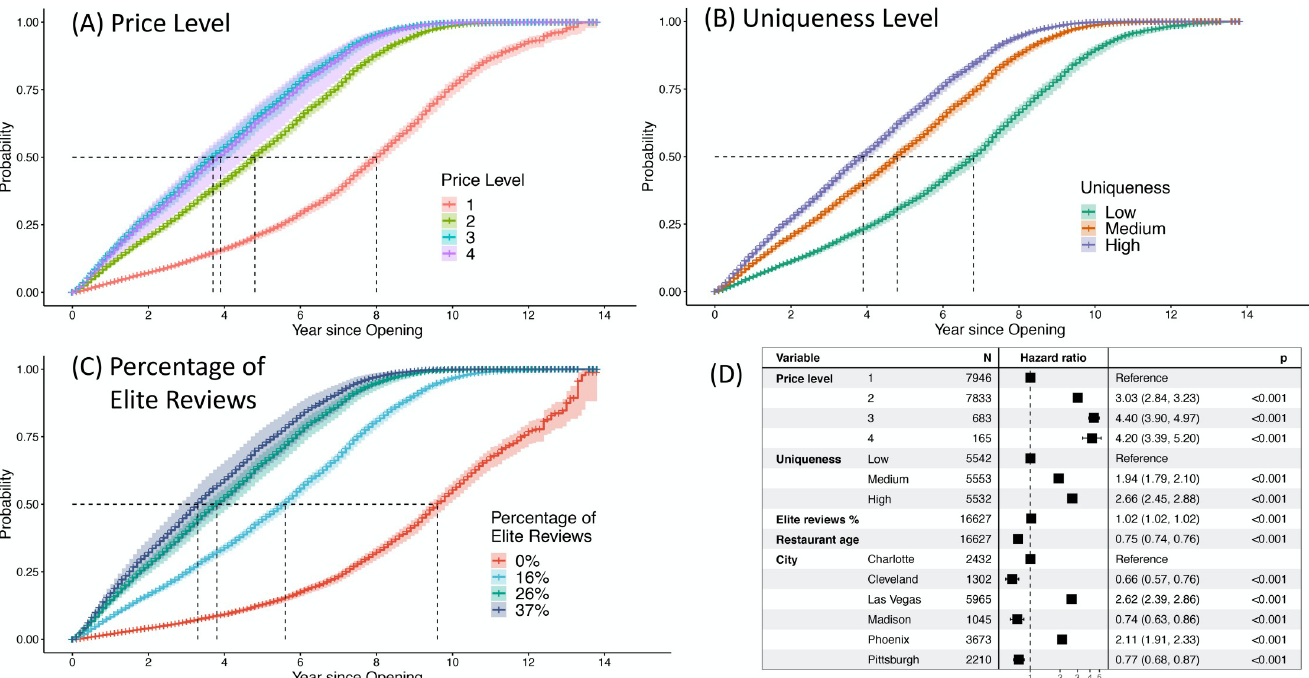
Fig 3. Incidence of achieving crowd wisdom. Cumulative incidence of achieving crowd wisdom (CW) with different price levels (A), uniqueness levels (B) and percentage of elite reviews (C) (zeroth to third quartile) at average restaurant age and in Las Vegas. The dotted lines show the time needed for 50% of restaurants in each category to achieve CW. The table (D) shows the hazard ratio (ratio of getting CW) among different categories of restaurants.